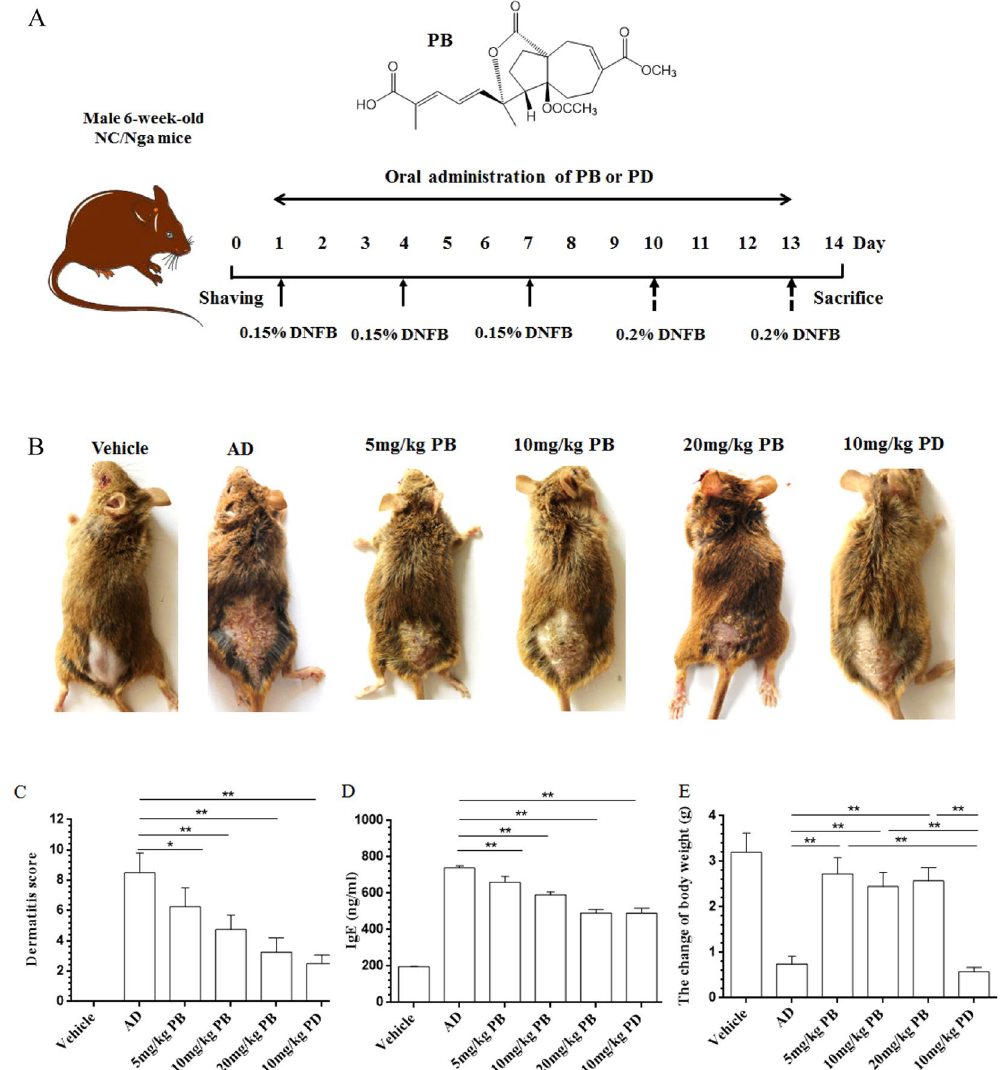
Figure 1. Improvement of PB on the clinical skin severity of AD-like skin lesions in NC/Nga mice. ( A ) Experimental protocol of AD-like lesions for sensitization and challenge with DNFB in NC/Nga mice. The NC/Nga mice were evoked by repetitive painting of 0.15% DNFB on dorsal skin once daily on days 1, 4 and 7, then further challenge with 0.2% DNFB on days 10 and 13. The treatment groups received PB (5, 10, 20 mg/ kg) or PD (10 mg/kg) orally from days 1 to 13. ( B ) Representative dorsal skin photographs of each treatment group showing comparison of AD-like skin lesions. ( C ) Overall dermatitis score was determined from the sum of all individual scores. ( D ) The concentration of total IgE in serum. ( E ) The changes in body weight of mice. Data are representative of two independent experiments and presented as mean ± SD of n = 8 mice per group. * p < 0.05, ** p < 0.01. Vehicle, intact mice with saline treatment; AD, DNFB-sensitized and challenged mice; PB, pseudolaric acid B; PD,